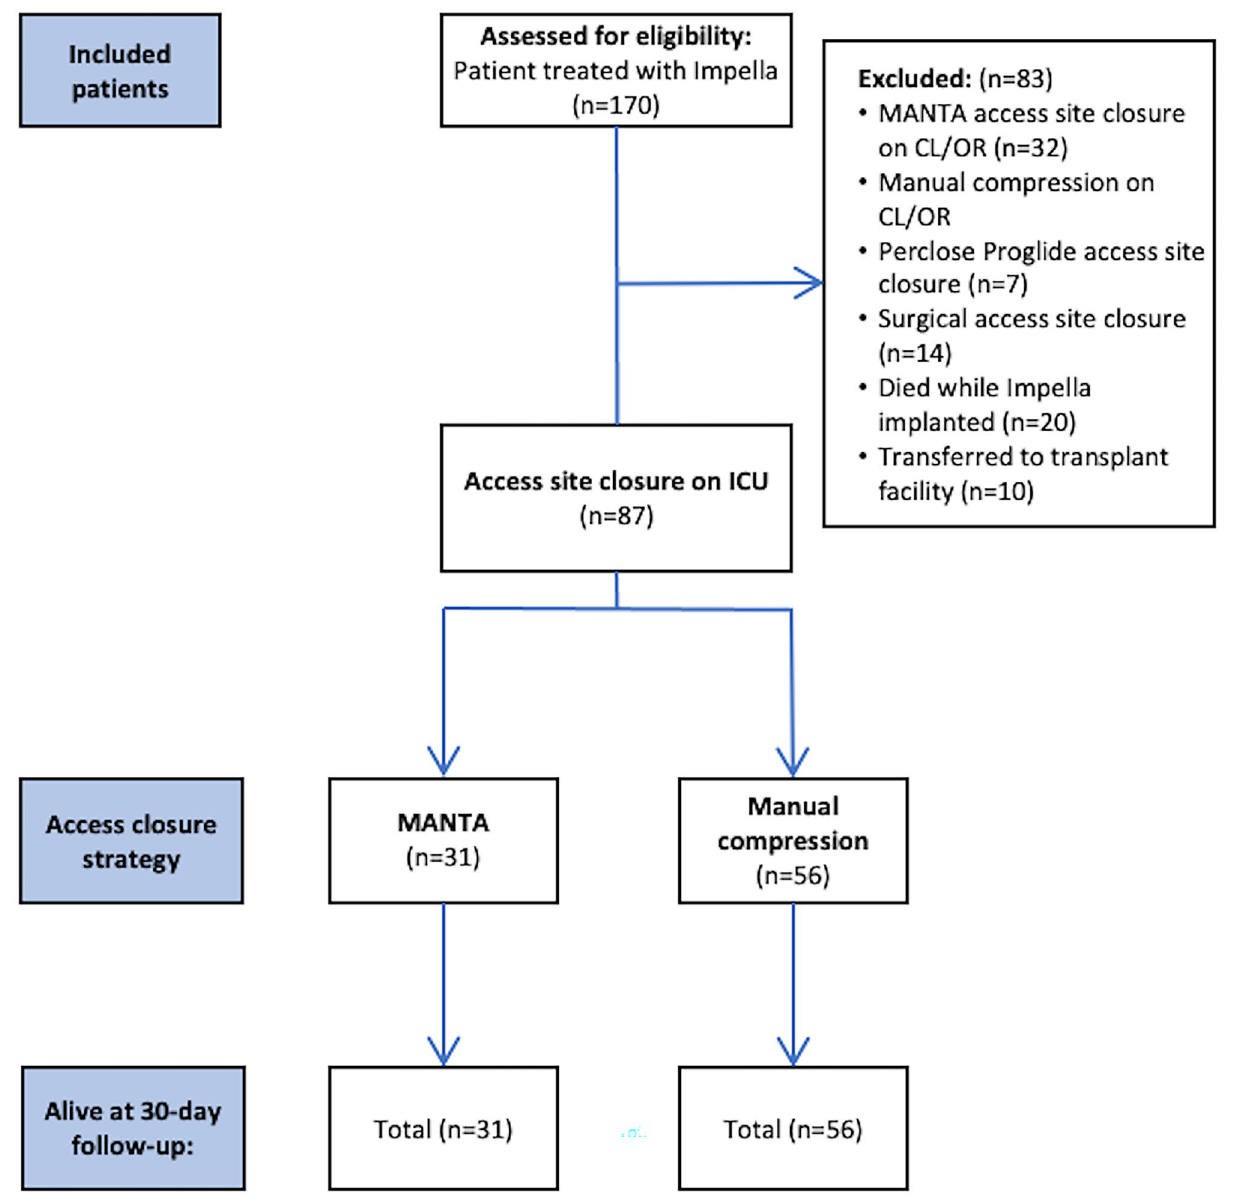
Figure 1. Study flow chart. MCS, mechanical circulatory support; ICU, intensive care unit; CL, catheterization laboratory; OR, operating